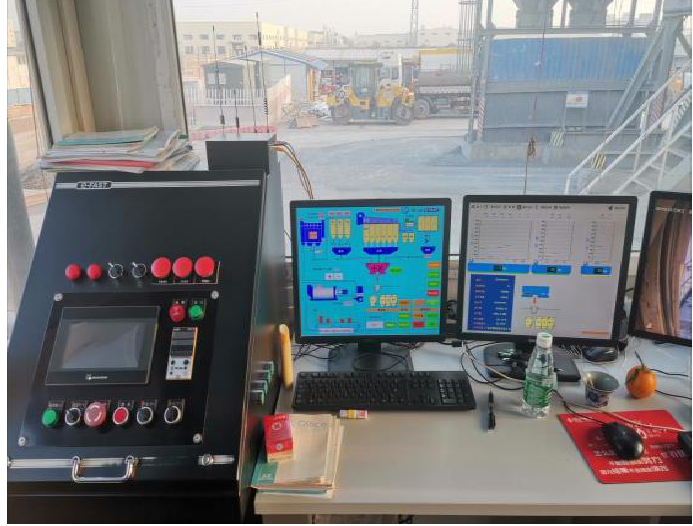
Figure 2. Data acquisition equipment in control room of mixing plant.